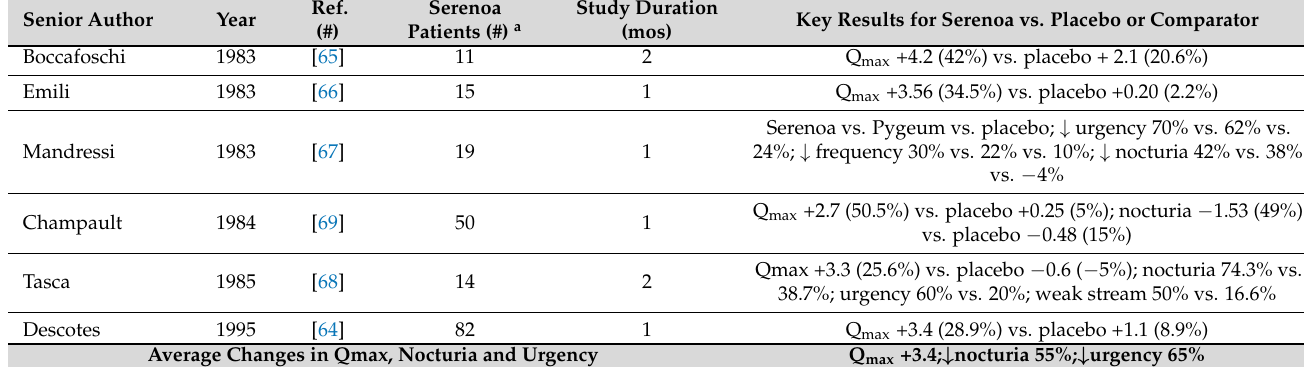
Table 3. Efficacy of the hexane extract of S. repens vs. placebo. Six of 20 non-evaluable studies in Cochrane 2012 used a standardized hexanic lipidosterolic extract and reported clinical improvement in symptoms vs. placebo. Key Results for Serenoa vs. Placebo or